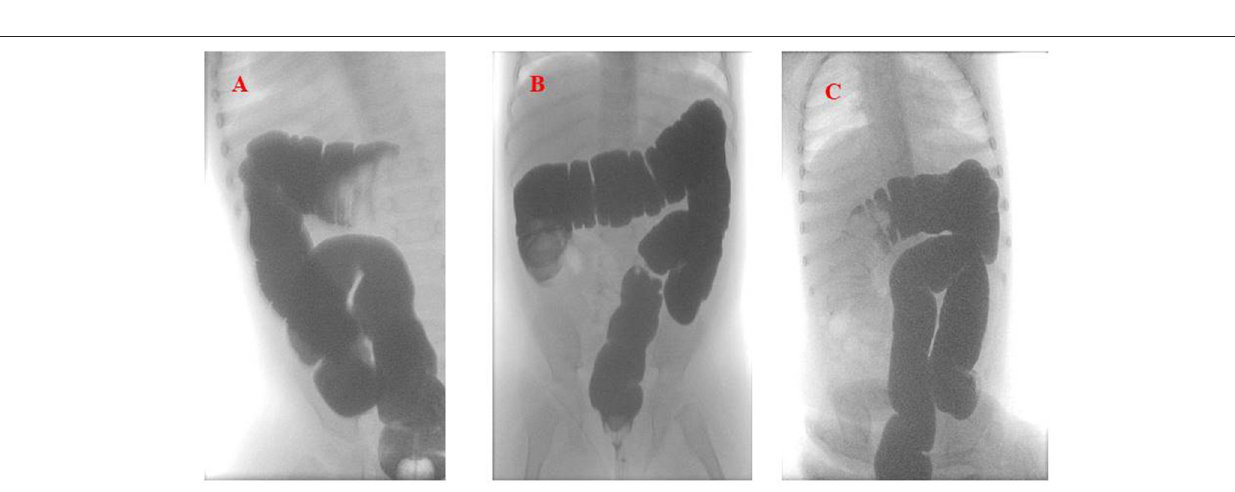
FIGURE 2 | Hydrostatic reduction of intussusception using Gastrografin ® contrast solution (A) . The first imaging shows the recurrence of the intussusception in the splenic flexure. (B,C) Show the relapses of the intussusception in the ascending and then back in the transverse colon,